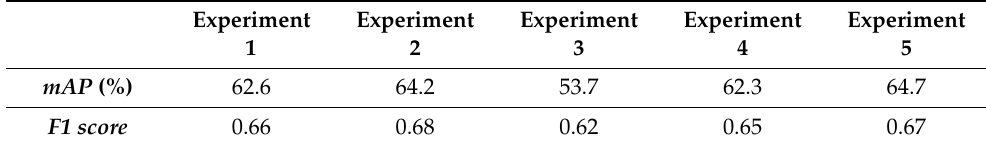
Table 13. Results of YOLOv4-TINY on CCTSDB2021 dataset.